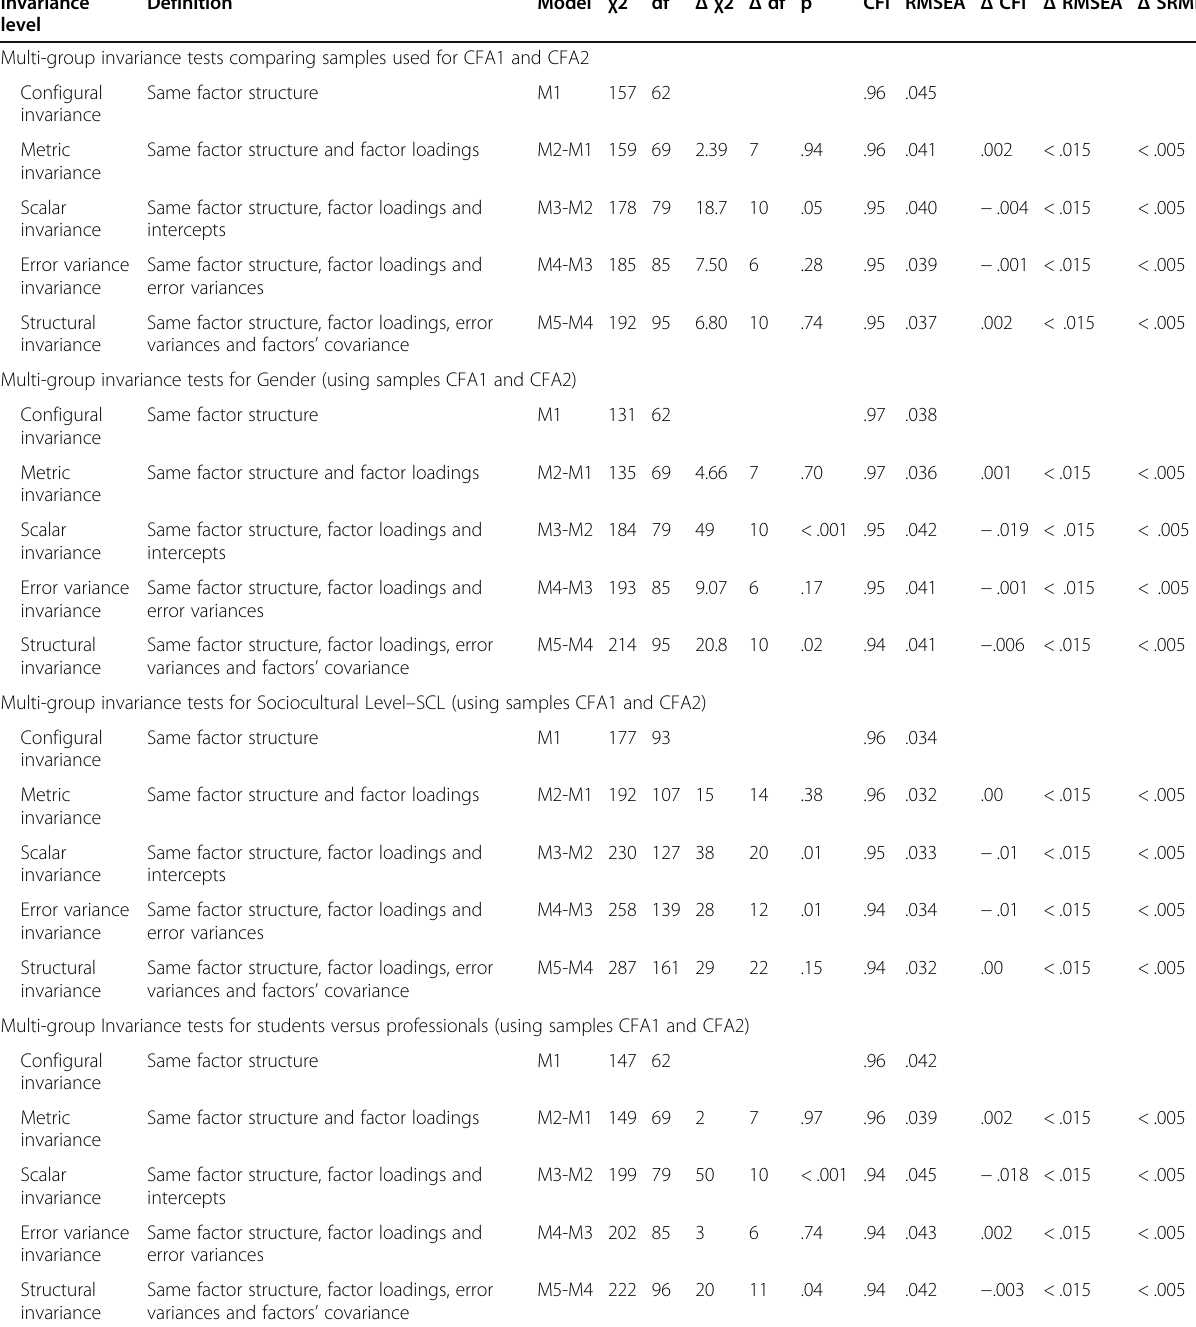
Table 3 Goodness-of-fit measurement invariance tests for PS-US Invariance